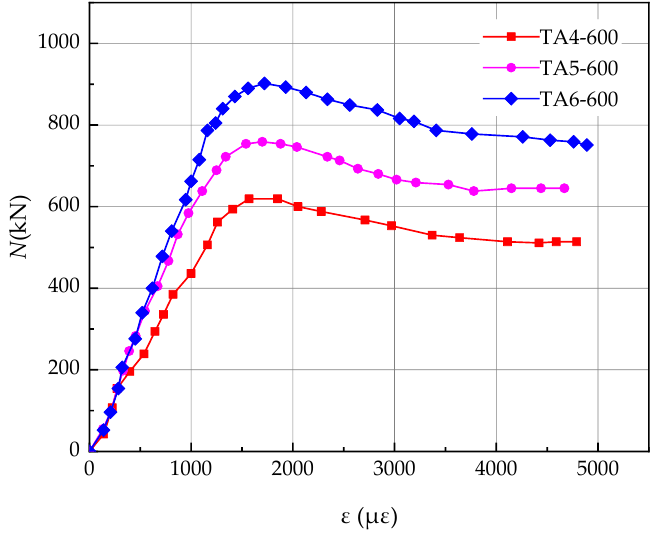
Figure 6. Axial load–strain relationship curve.